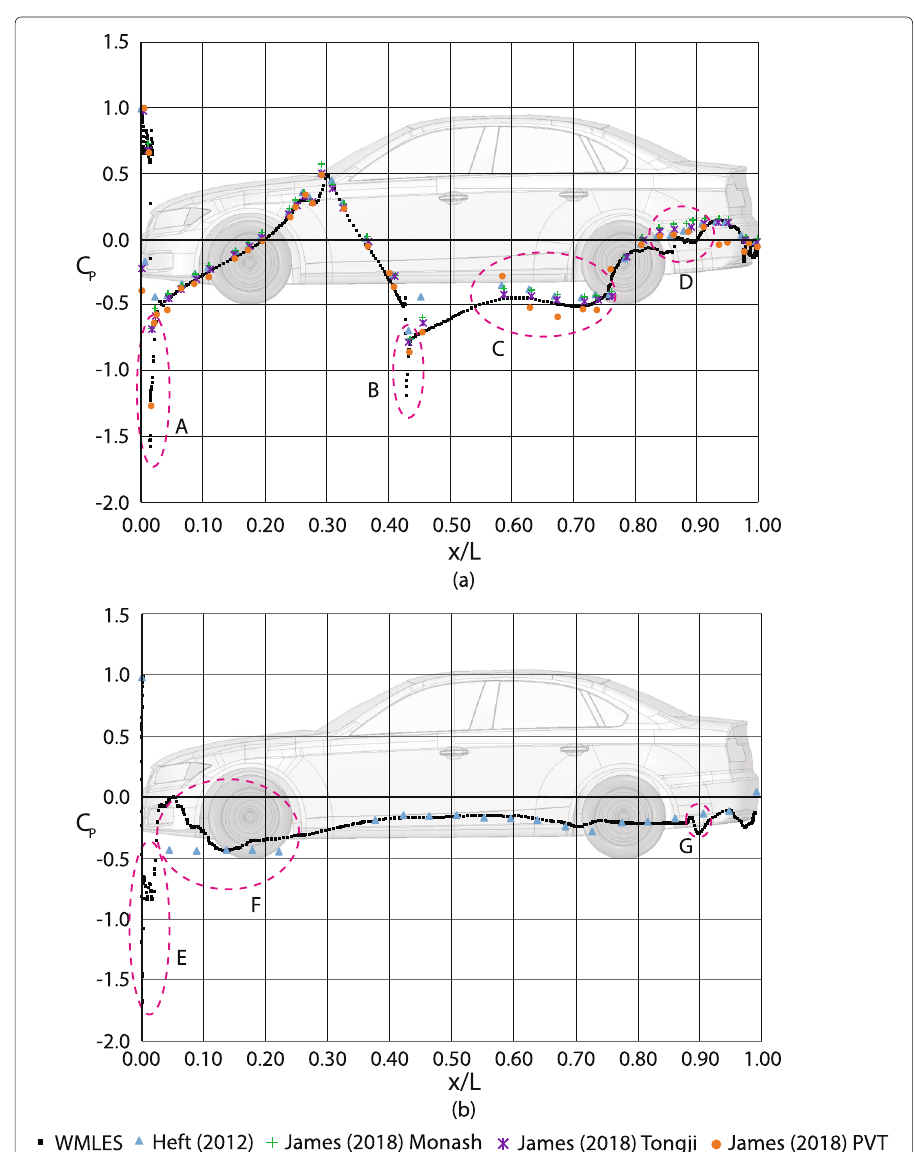
Fig. 7 Pressure coefficients along the center plane of the notchback DrivAer model to compare present WMLES ( U ∞ = 15 m/s) with available experimental data ( a ) upperbody and ( b ) underbody